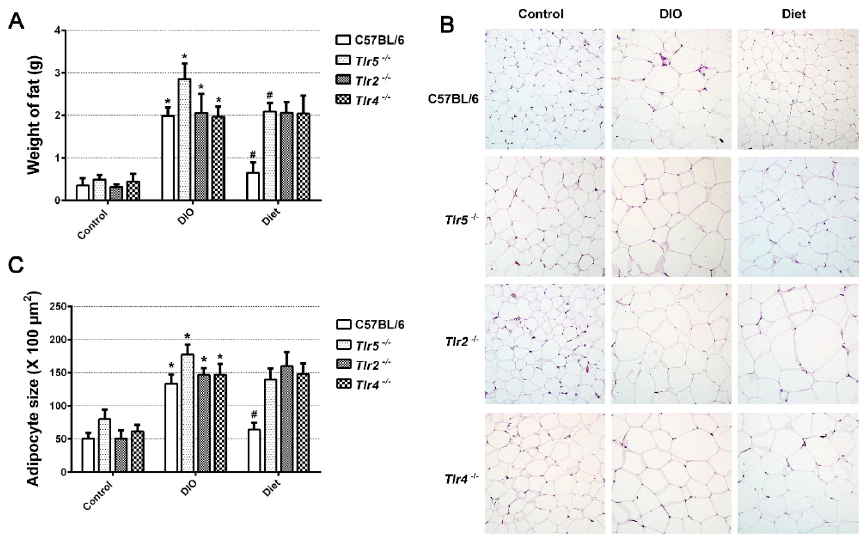
Figure 2. ( A ) The weight of epididymal fat pad, ( B ) hematoxylin and eosin stained 5 µm section of paraffin-embedded epididymal fat pad of C57BL/6 and Tlr knockout mice in the control and DIO groups, obtained on the twelfth week, ( C ) size of adipocytes in C57BL/6 and Tlr knockout mice. * p < 0.05 vs. control. # p < 0.05 vs.